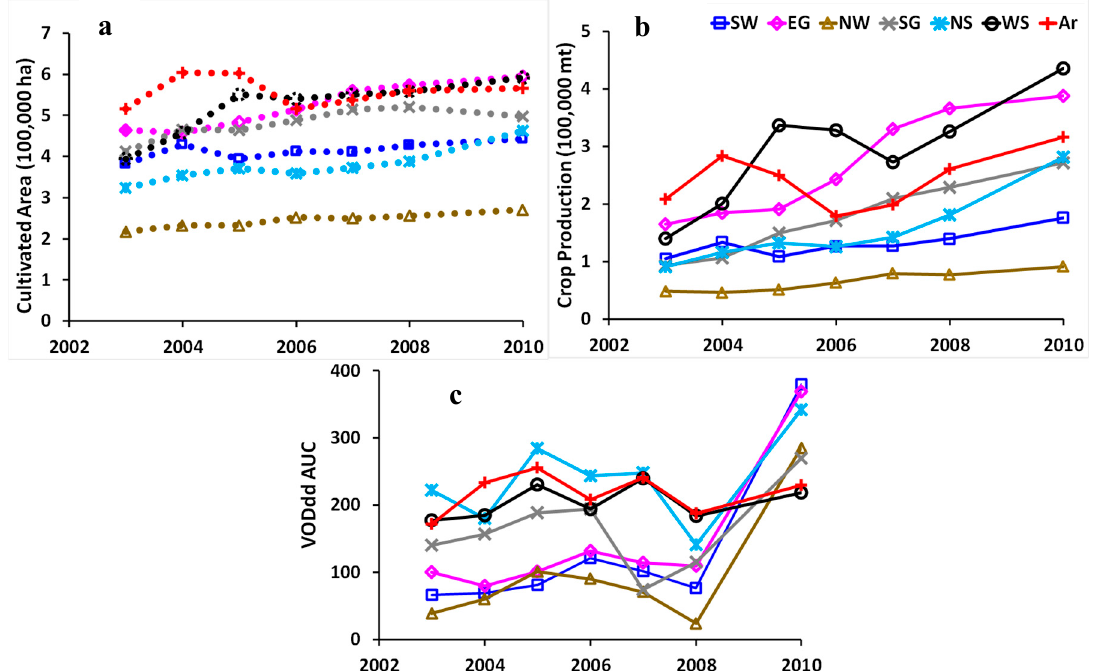
Figure 13. Time series graphs of ( a ) cultivated area, ( b ) crop production, and ( c ) VODdd AUC in five zones (SW = South Wollo, EG = East Gojjam, NW = North Wollo, SG = South Gondar, NS = North Shewa, WS = West Shewa, and Ar = Arsi. Note the differences in rates of change of the crop production data relative to the VODdd AUC satellite derived data.